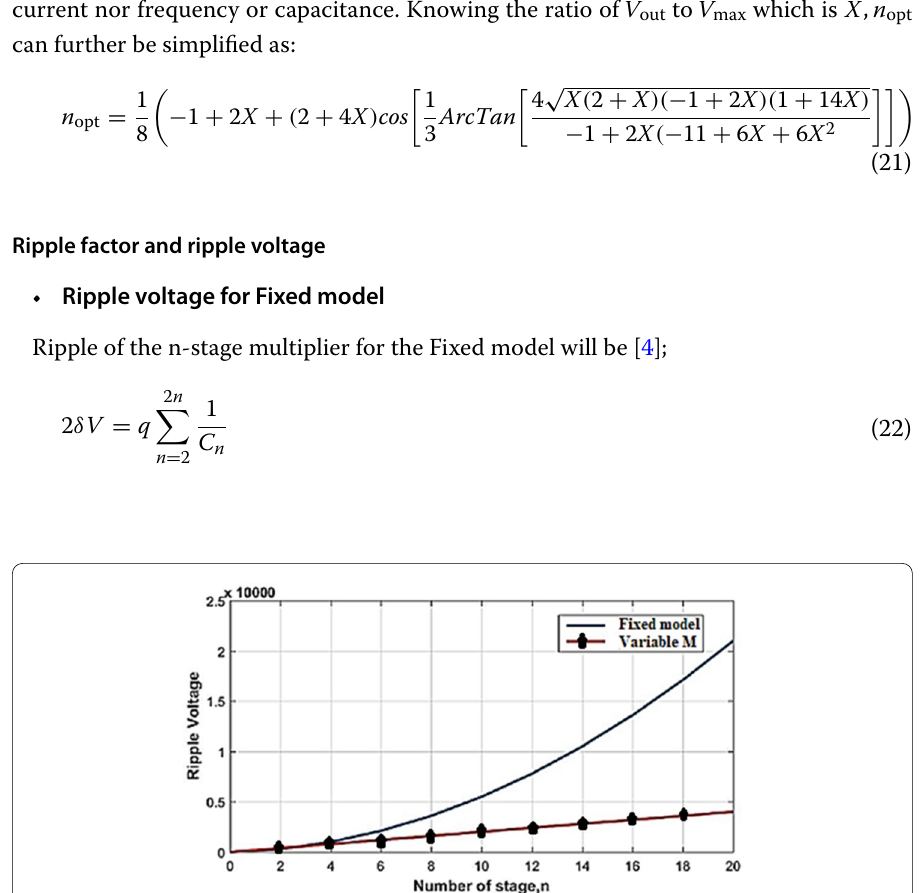
Fig. 3 Variation of Ripple with number of stages in